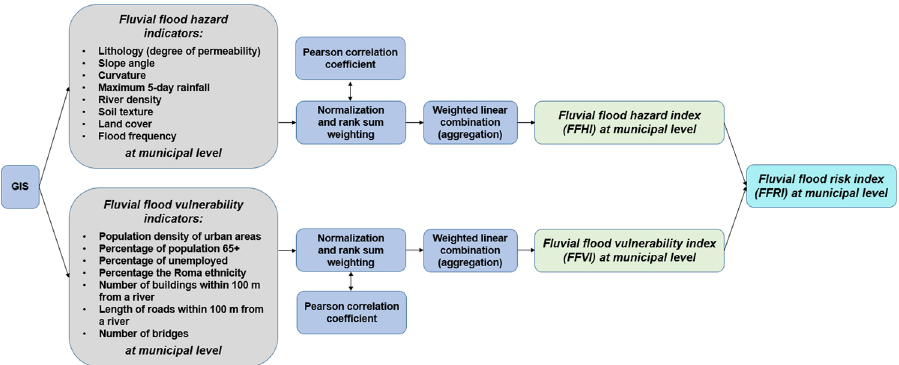
Figure 2. Methodological approach used in this